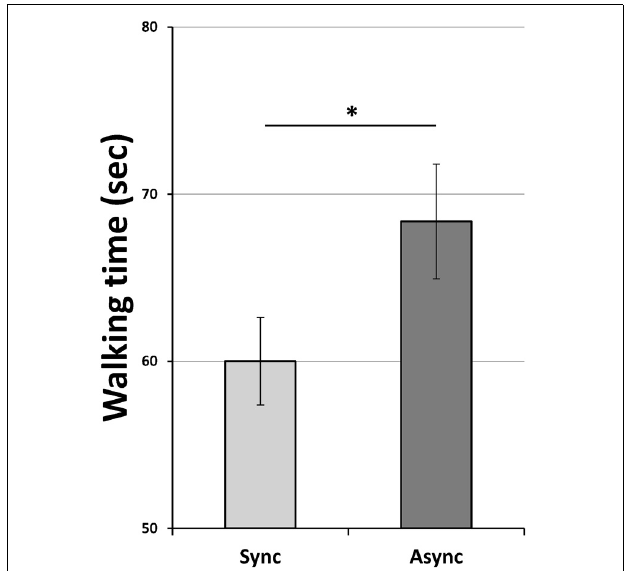
FIGURE 5 | Mean walking time to drive the robot from the first to the second table and drop the bottle. Light-gray and dark-gray columns represent Synchronous and Asynchronous footstep sound heard by participants. Error bars represent s.e.m. Asterisk indicate significant comparisons ( p < 0 . 05).